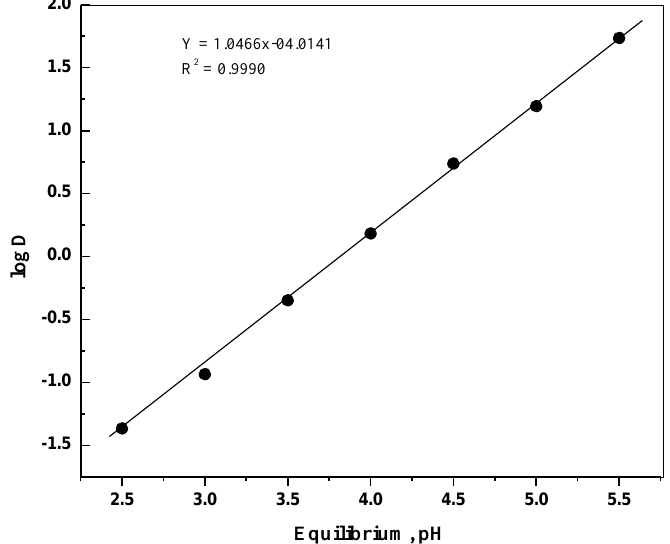
Fig. 2. Plot of log D vs equilibrium pH, Conditions:15% (v/v) furfuryl thioalcohol in kerosene, O/A=1, Na 2 SO 4 = 0.5 mol L -1 , equilibrium time 10